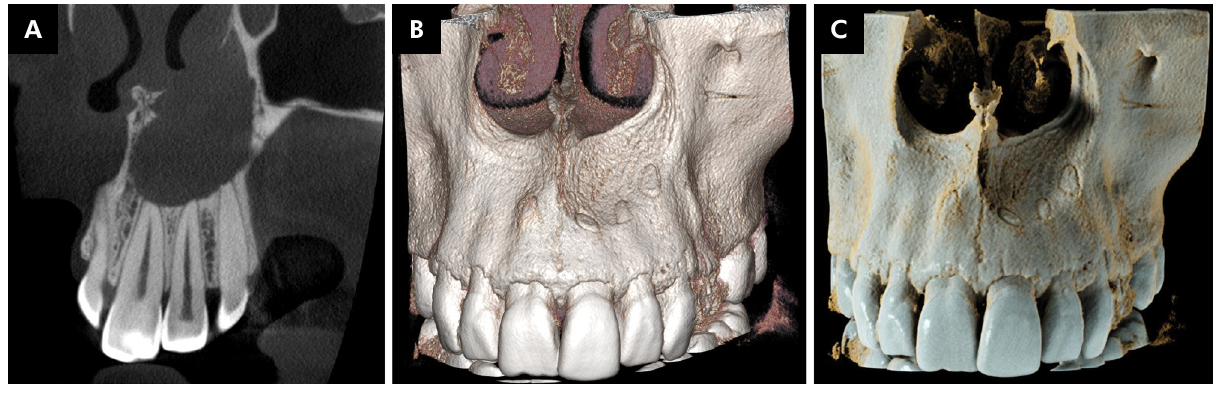
Figure 3. Case 2 (A-C). A 40-year-old woman was referred to a private oral and maxillofacial radiology clinic (CROIF, Cuiabá, Brazil) for imaging studies to assess a volumetric increase of the apical region of left maxillary incisors and canine. Her medical history was negative for any comorbidities. CBCT scans showed bone depression above the apex of teeth #21, #22 and #23, as well as resorption in the apical region of the same teeth (A-C). A soft tissue lesion in the region was removed, and histological analysis of the specimen revealed a nasolabial cyst. The e-Vol DX software and its advanced photorealistic 3D rendering tool (C) provided information for the evaluation of the bone depression in relation to the nasal fossa, data that was important to make a decision about the extent of the surgical